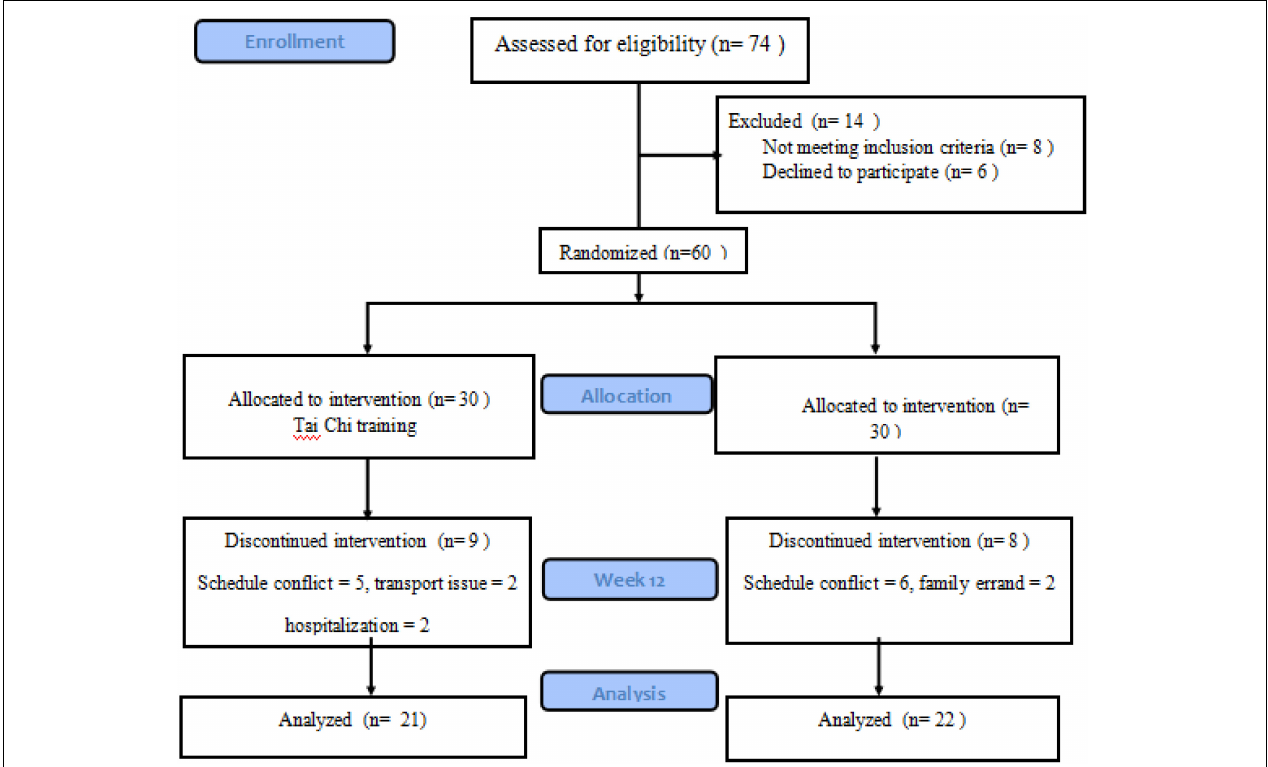
FIGURE 1 | Flowchart of enrollment, baseline, and